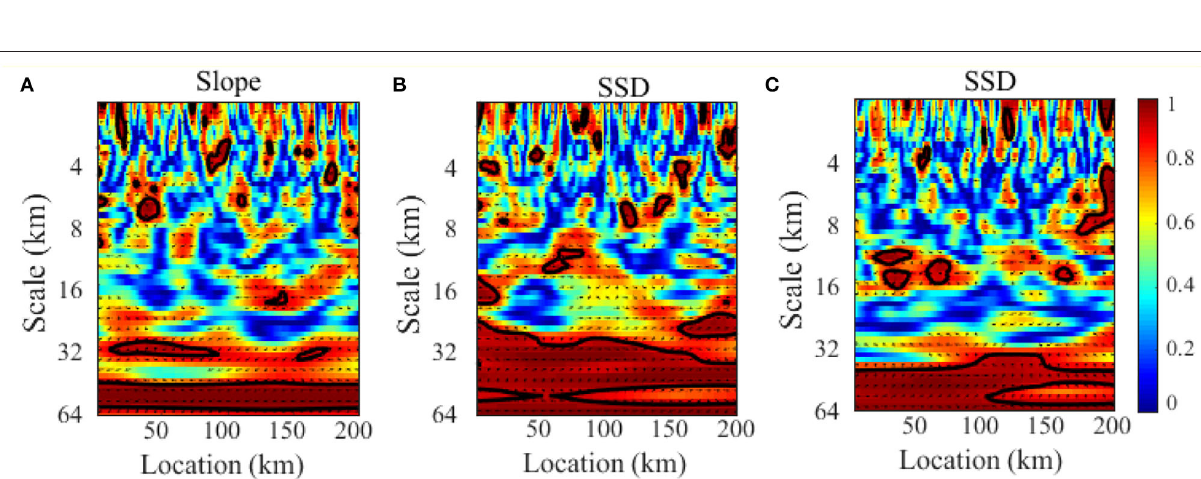
FIGURE 3 | Correlation coefficients between the temporal change of soil nitrogen density (SND T ) and its controlling factors or their decomposed scale components by continuous wavelet transform (CWT) along the (A) cool-temperate, (B) mid-temperate, and (C) warm-temperate transects. The x-axis indicates the original scale or the decomposed scales of the environmental factors.